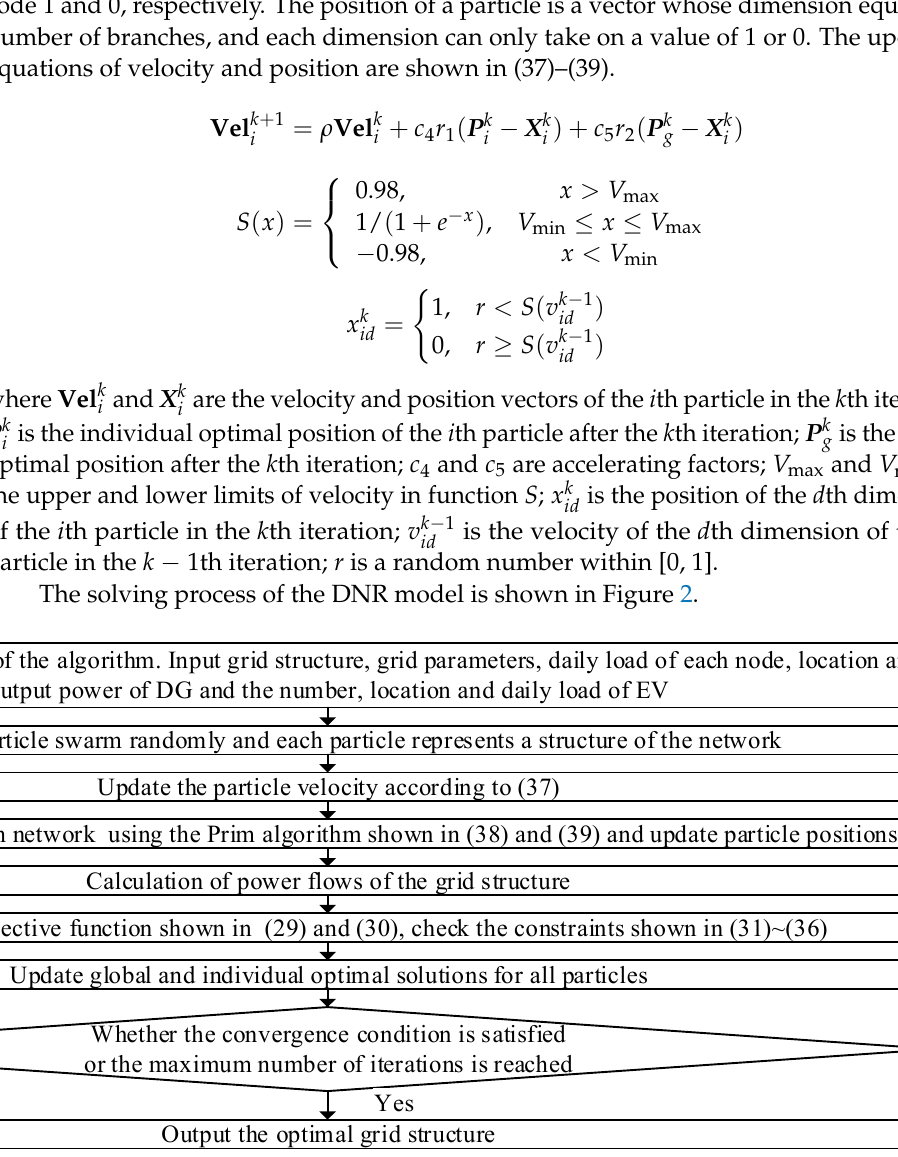
Figure 2. Solving process of DNR model.